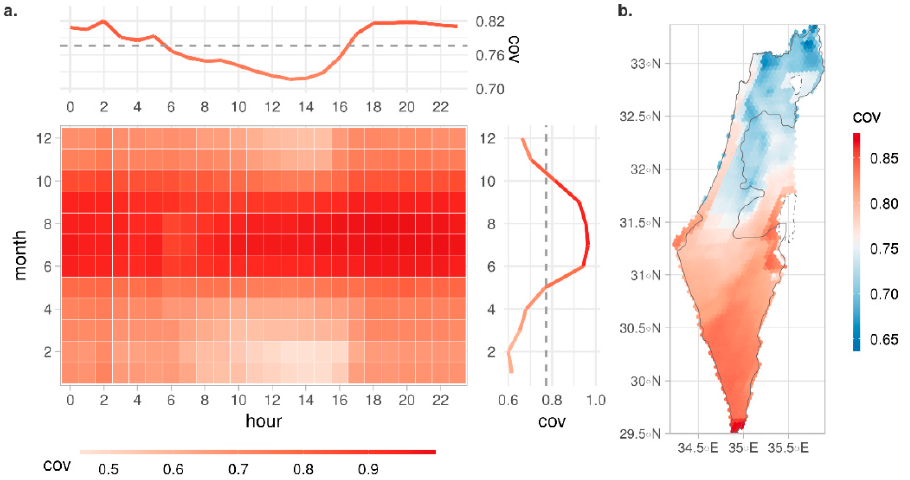
Figure 4. Temporal ( a ) and spatial pattern ( b ) of the clear-sky ratio (cov = number of clear-sky observations / total number of observations) for SEVIRI Ts data (2004–2017).